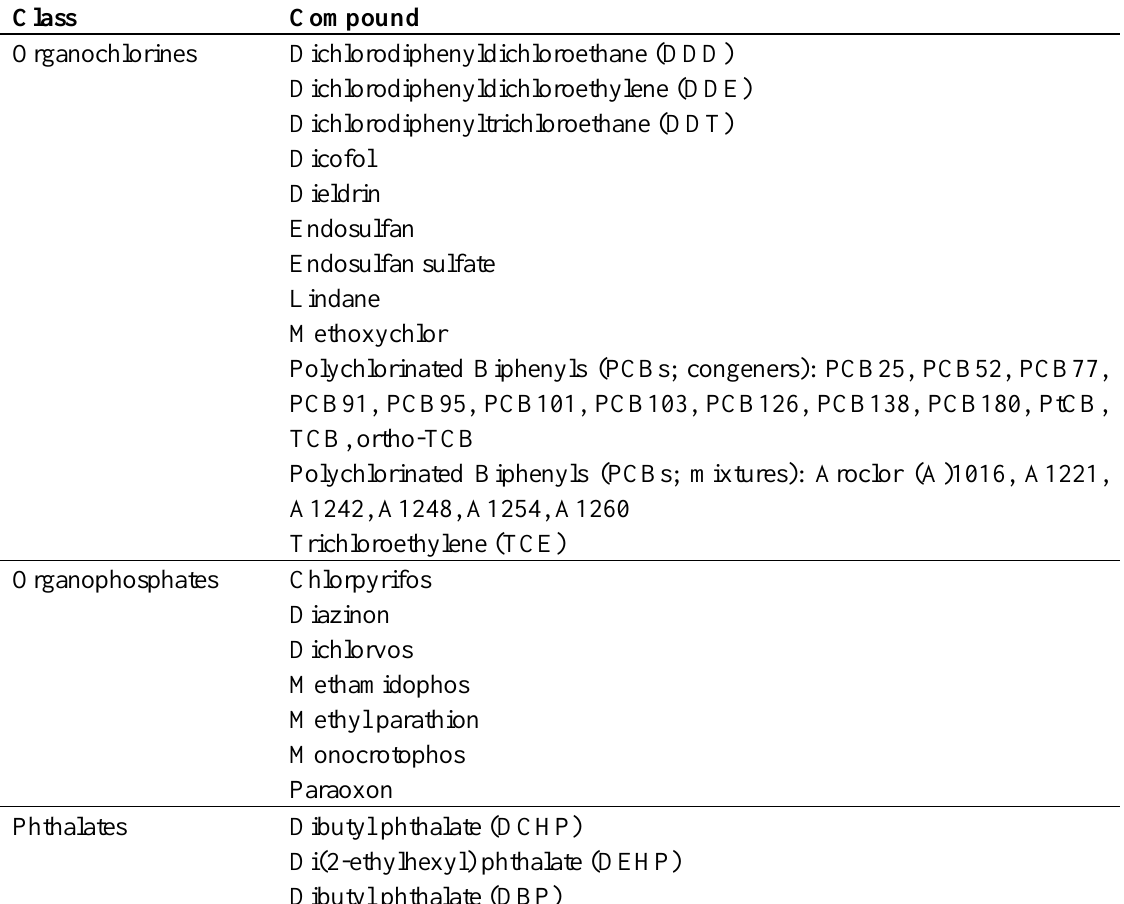
Table 1. Neurotoxic compounds,